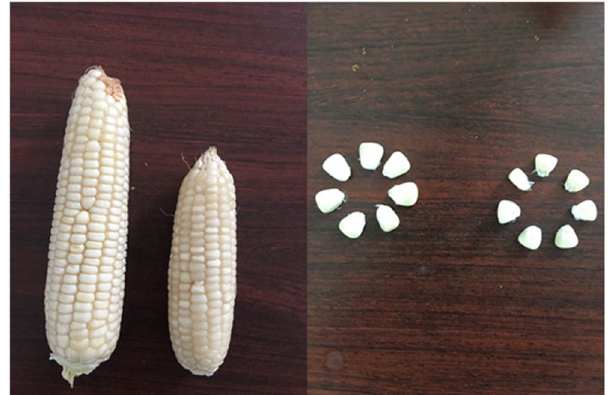
Figure 1. Pictures of ear and grains under ambient (left) and high-temperature (right) conditions.